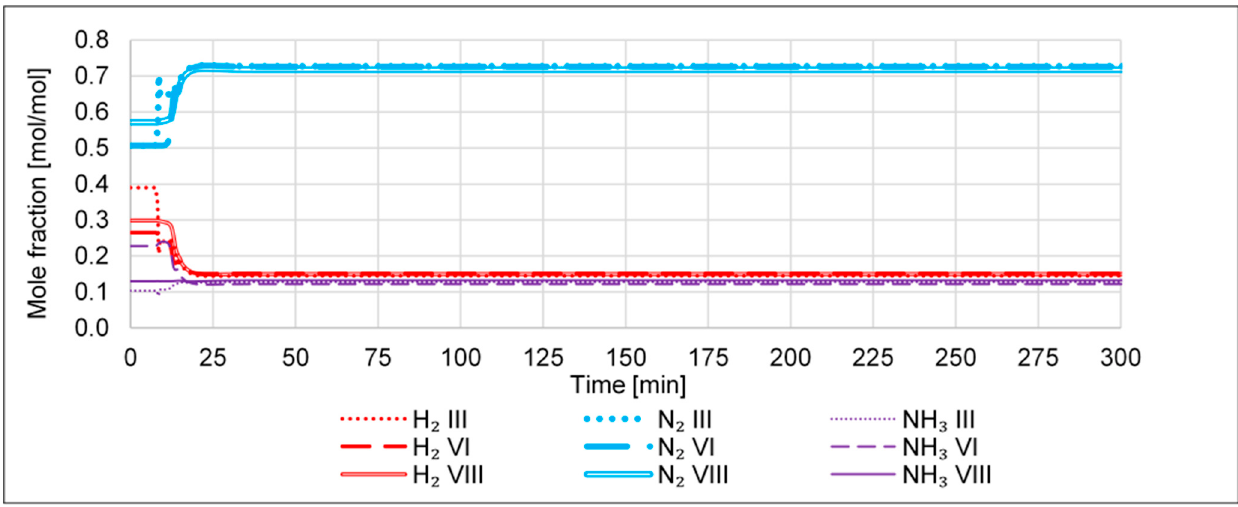
Figure 10 . Selected mole fractions of scenario (d). Figure 10. Selected mole fractions of scenario